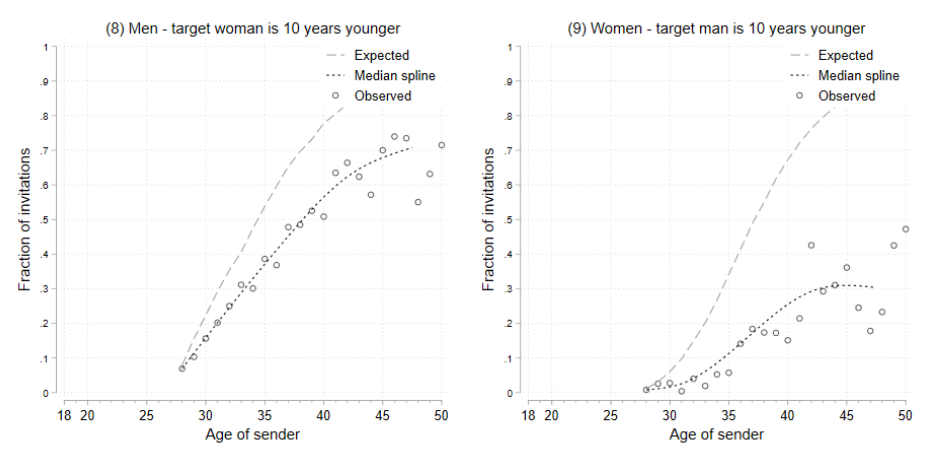
Figure 8 and 9 : Observed and expected fractions of initial messages sent to 10+ years younger